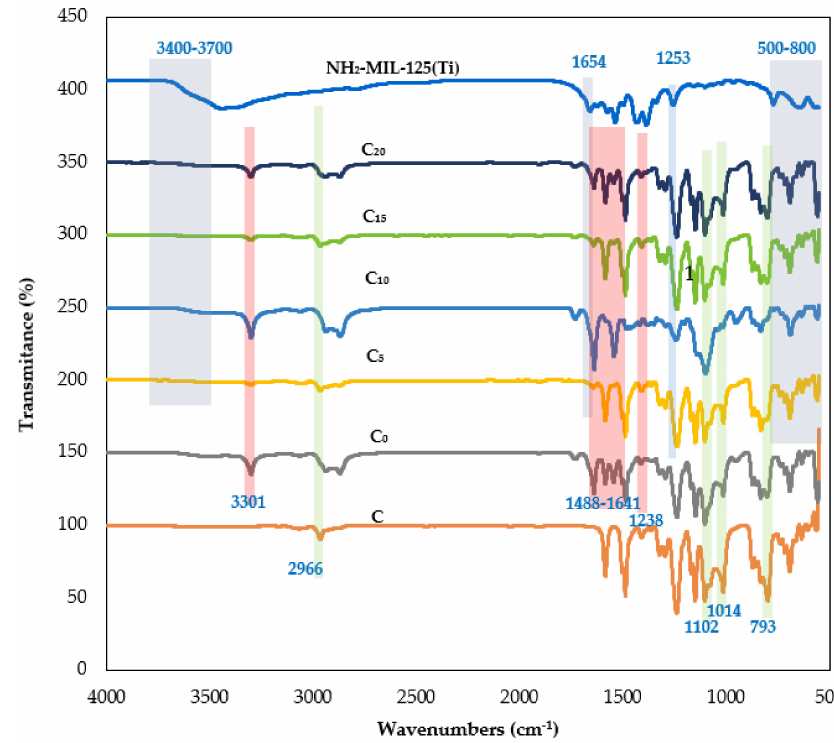
Figure 3. FTIR spectra of fillers and composite hollow fiber membranes.